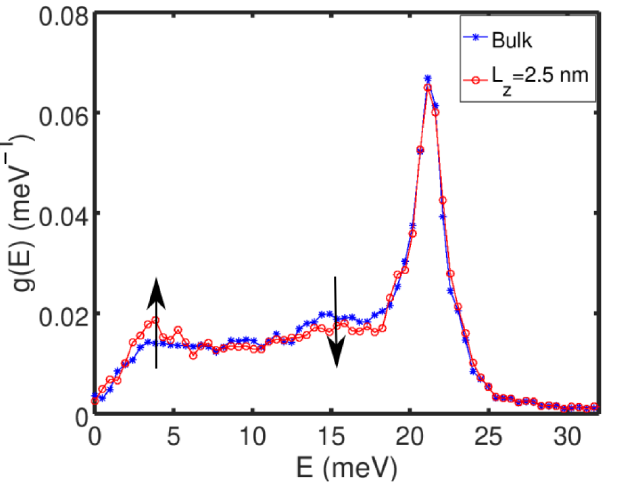
Figure 3. Partial vDOS in the HS state for a film of thickness L z = 2.5 nm (red open circles). The vDOS corresponding to the simulated bulk material is shown for comparison (blue full circles). Similar results were obtained for the LS state (see Supplementary Materials, Figure S1). The arrows indicate the changes in the